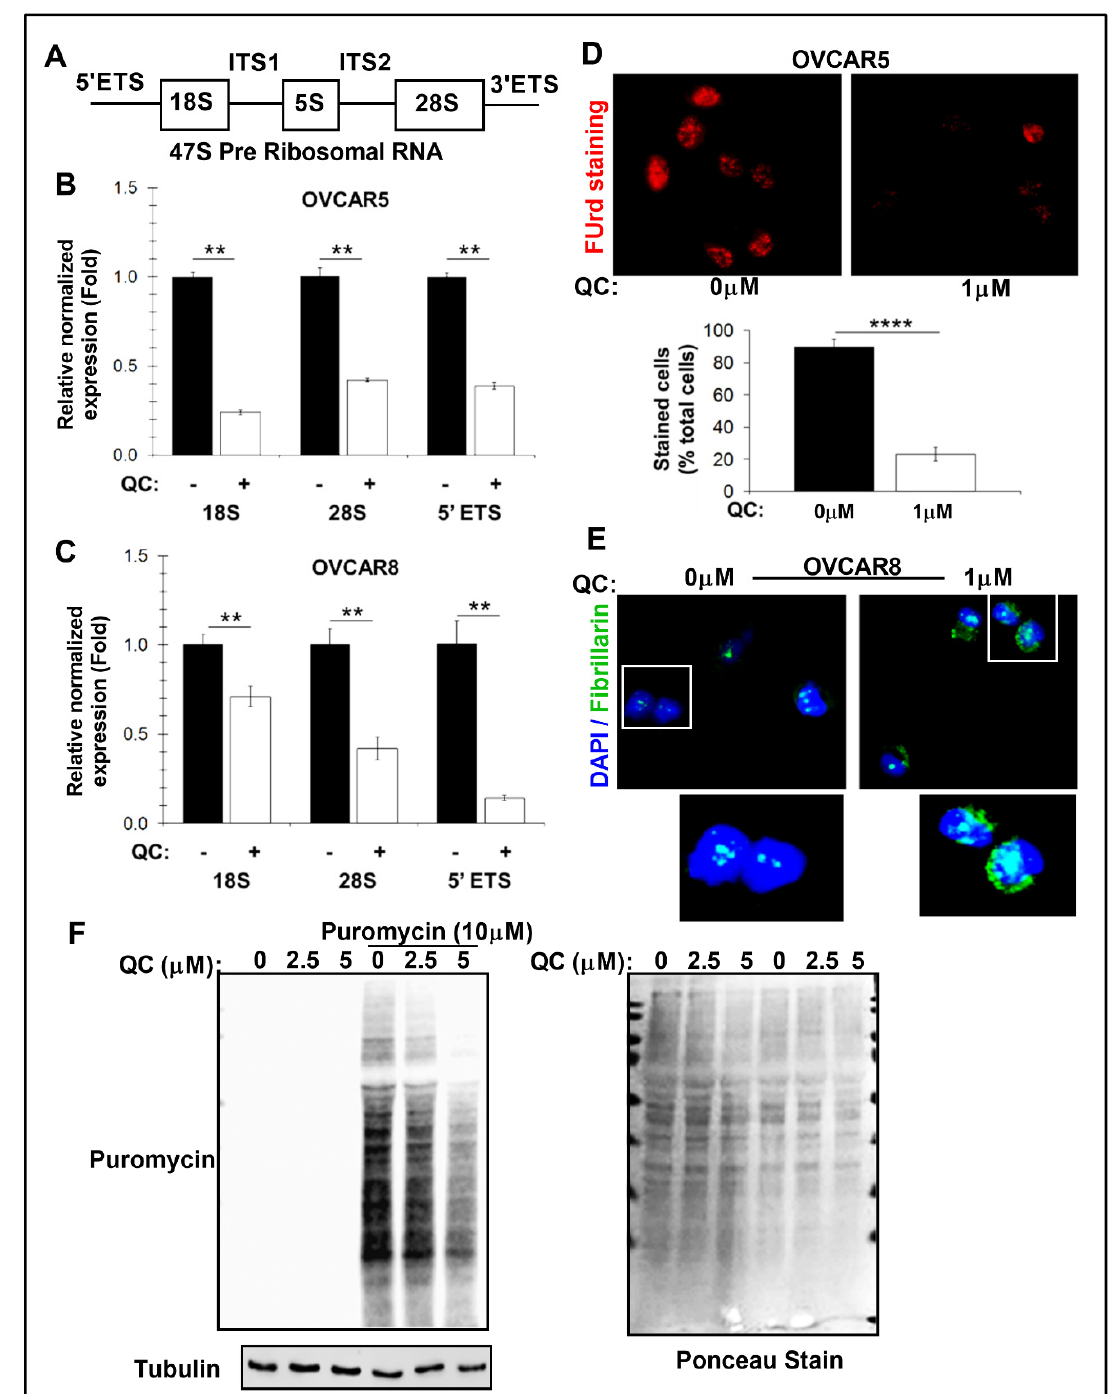
Figure 2. QC impairs RBG and induces nucleolar stress in OC cells. ( A ) Graphic representation of 47S pre-ribosomal RNA. ETS–external transcribed spacers, ITS–internal transcribed spacers. ( B ) Relative expression changes for ribosomal subunits after 1 h of 1 µM QC treatment in OVCAR5 and ( C ) OVCAR8 cells (normalized to RPLP0; n = 3). Error bars represent standard error, and significance is denoted by ** ( p < 0.01). ( D ) Incorporation of 5-fluorouridine was monitored after 10 min of labeling in OVCAR5 cells treated with 1 µM QC for 2 h. Representative images were shown, quantified and shown as bar graph **** ( p < 0.0001). ( E ) Fibrillarin (Green) IF staining was performed after 2 h of 1 µM QC in OVCAR8 cells. DAPI was used to stain nucleus. ( F ) Whole cell lysates of OVCAR5 were analyzed for puromycin incorporation (1 h, 10 µM) with increasing QC concentrations. Membrane with Ponceau stain was shown for protein loading. Abbreviations: QC: Quinacrine; ITS1/2: internal transcribed spacers 1 and 2; 5 ′ /3 ′ ETS: external transcribed spacers; FUrd: 5-fluorouridine.